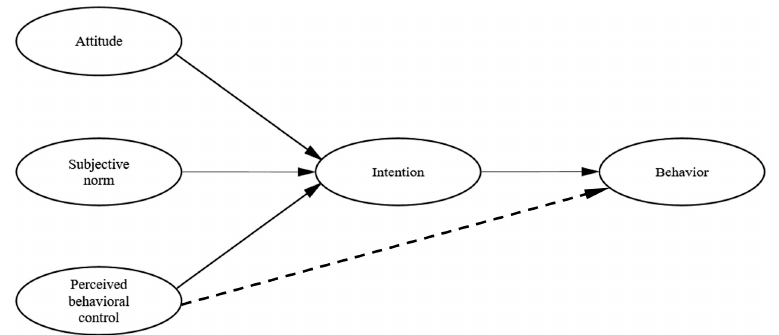
Figure 1. Model of the theory of planned behavior, dotted line indicates the impact of actual behavioral control.